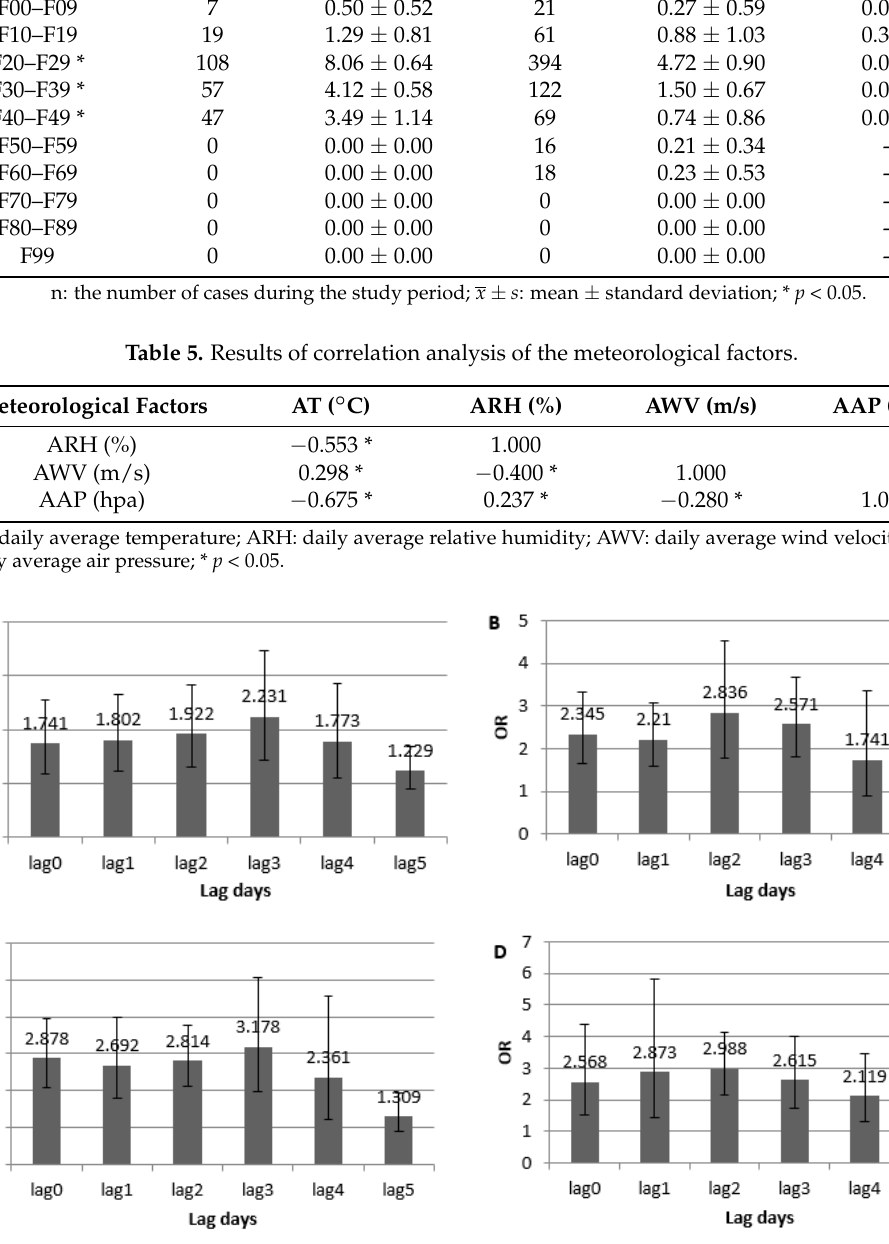
Table 5. Results of correlation analysis of the meteorological factors.